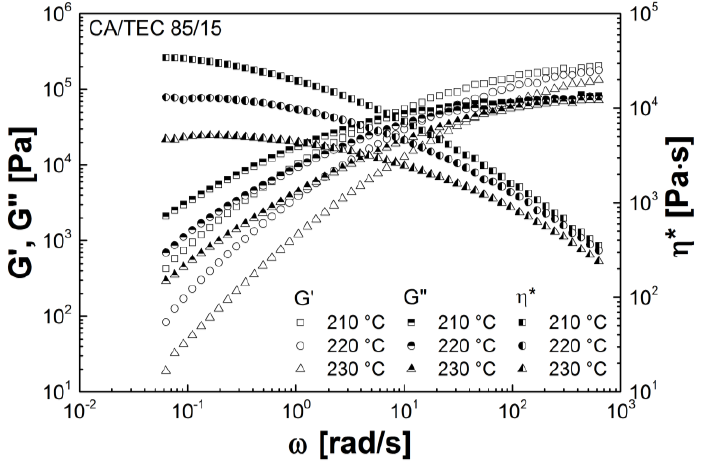
Figure 7. Storage modulus, loss modulus, and complex viscosity of CA/TEC (85/15) as a function of radial frequency dependent on